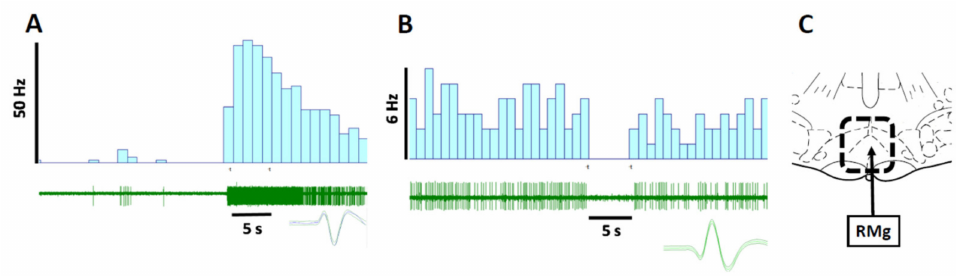
Figure 5. Examples of original recordings of an ON-like neuron ( A ) and an OFF-like neuron ( B ), and the recording area in the rostral ventromedial medulla ( C ). In ( A , B ), the uppermost graph shows a peristimulus time histogram, the middle one an original recording, and the lowermost a graph template of the studied neuron. The horizontal time bar indicates the time and duration of the noxious tail pinch used to classify the neuron based on its stimulus-evoked response. In ( C ), the area surrounded by the dotted line in the section that is 2.3 mm caudal to the ear bar indicates the area of the verified recording sites. RMg = raphe